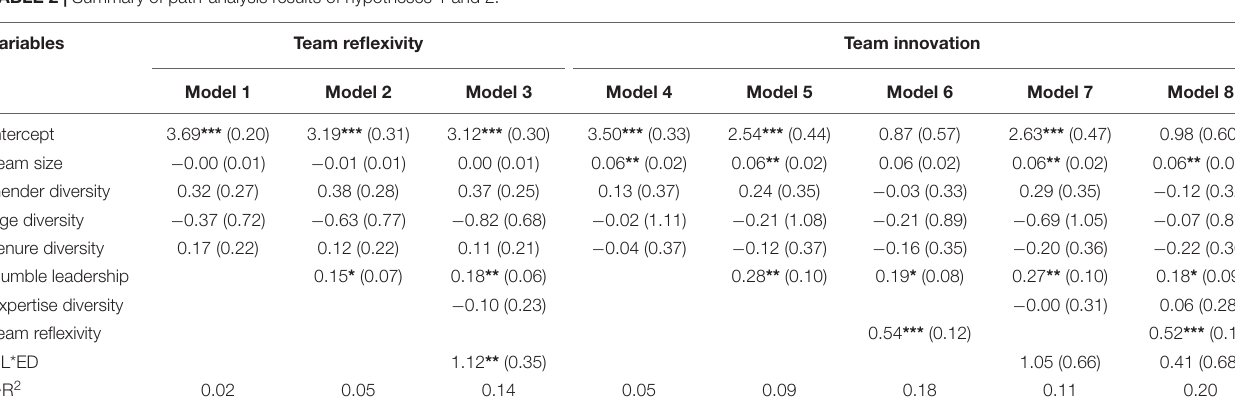
TABLE 2 | Summary of path-analysis results of hypotheses 1 and 2.